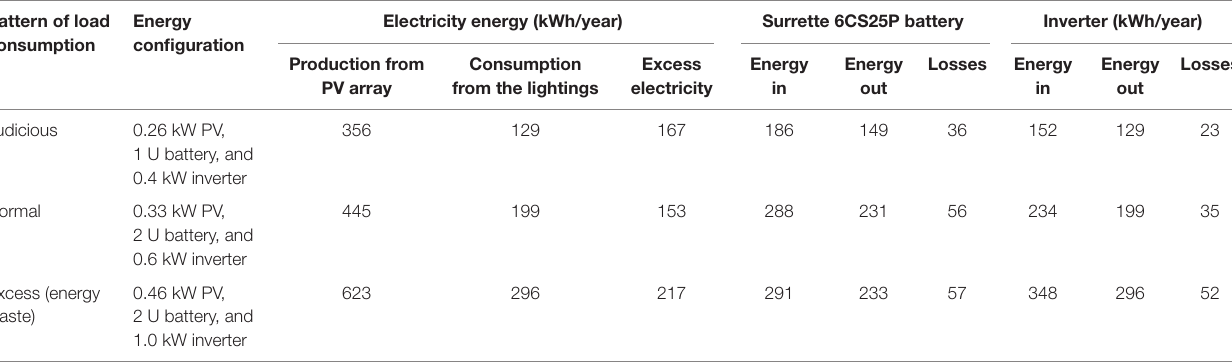
TaBle 2 | simulation results of electricity production, consumption, and losses (with surrette battery).